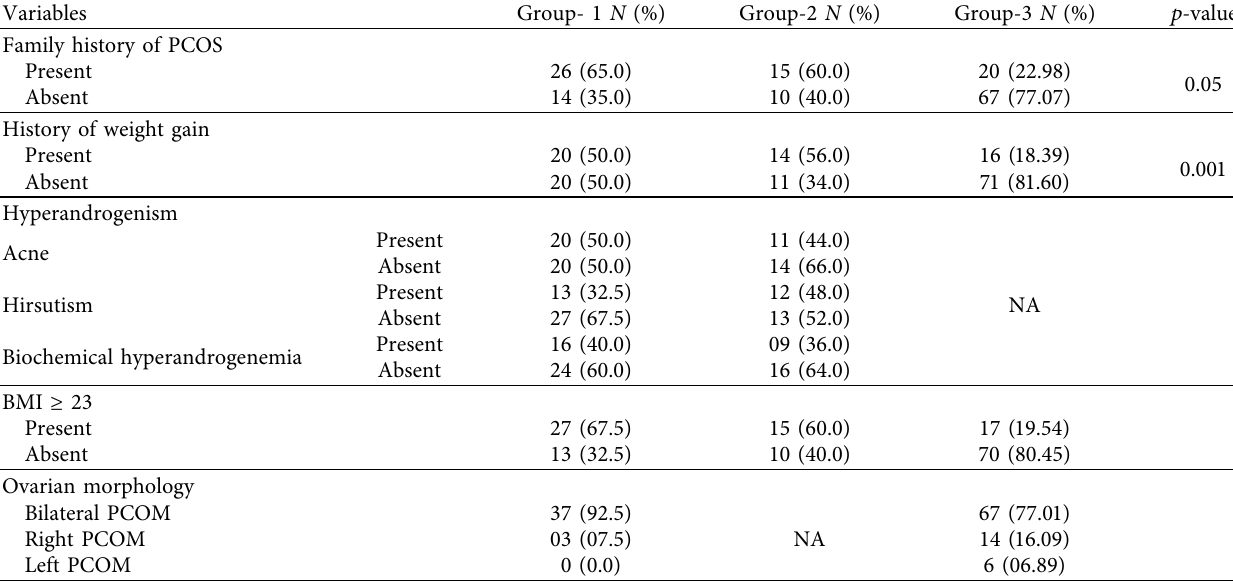
Table 3: Clinical characteristics of different phenotypic groups of adolescents with menstrual irregularities. Variables